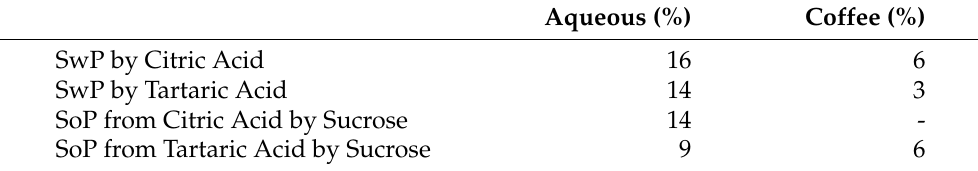
Table 7. Mean suppression percentages for the different matrices. Only when the difference between the sample with and the sample without suppressant is significant is the suppression percentage shown. SwP is Percent Sweetness Suppression, SoP is Percent Sourness